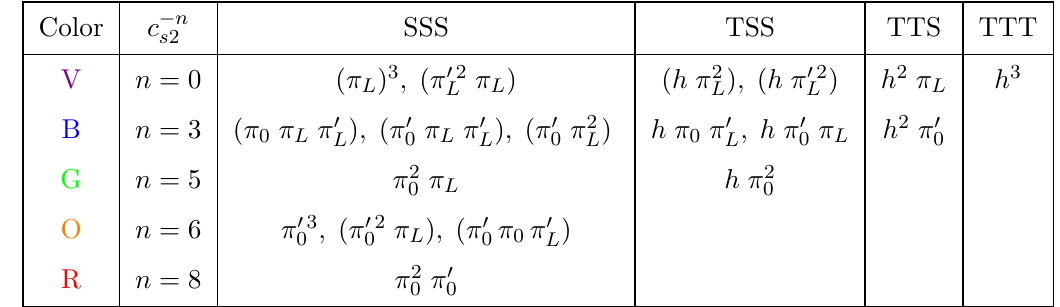
Table 1 . Operators in the cubic Lagrangian (5.1) classified according the powers c − n of the corresponding contribution to (cid:10) ζ 3 divergences are not as stiff as in the c 2